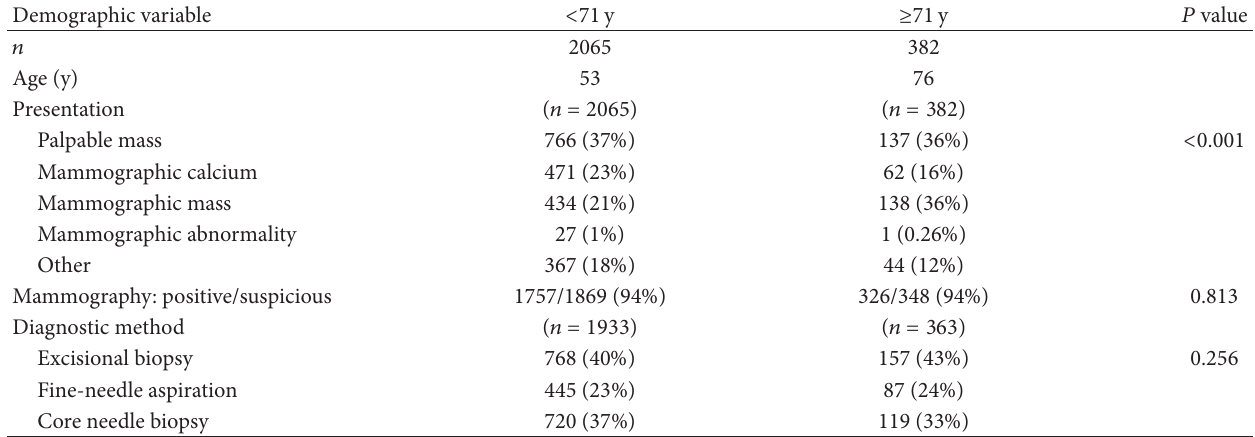
T 1: Comparison of demographic variables in